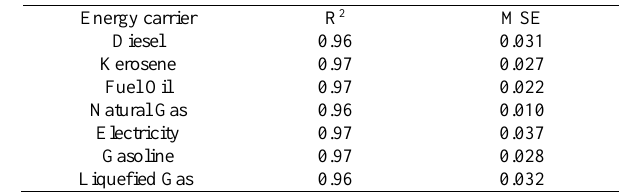
Figure 6.Variations of MSE versus the number of neurons, coefficient of momentum and learning rate for the created network for natural gas